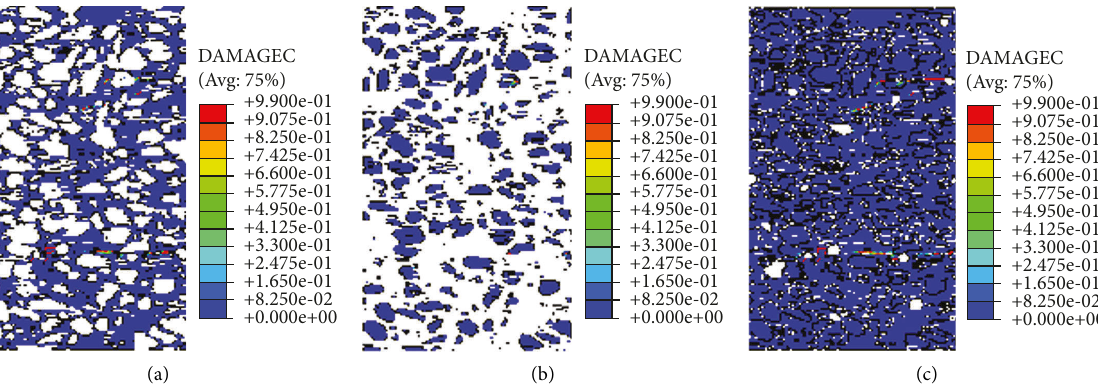
Figure 21: Damage graphs of different materials when the loading displacement is 0.12 mm. (a) Mortar. (b) Aggregate. (c)